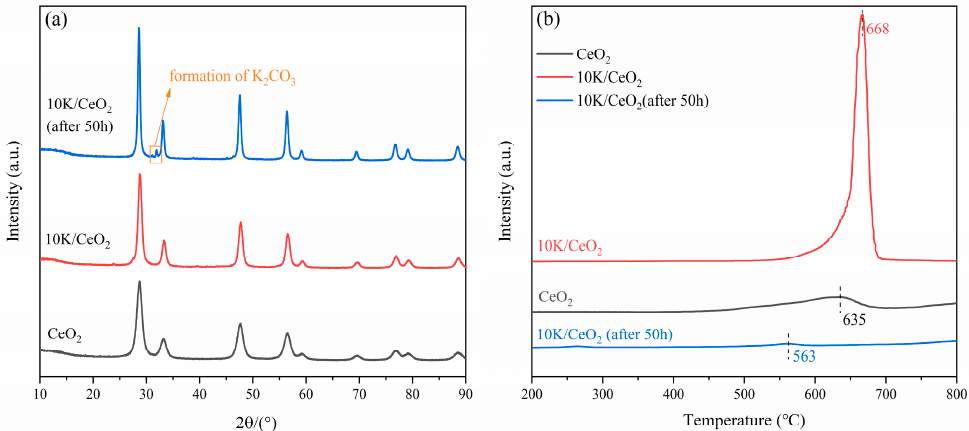
Figure 10. Sample characterization before and after stability testing of 10%K/CeO 2 . ( a ) XRD and ( b ) H 2 -TPR. ( b ) H 2